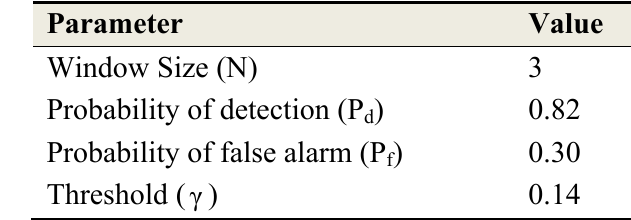
Table 1. Parameters selected for the QSF